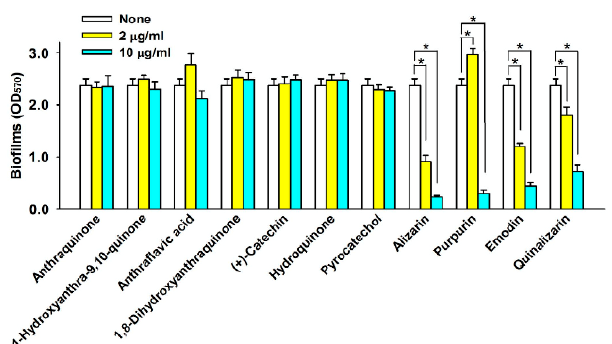
Figure 1. Inhibition effects of cinnamic and salicylic acids on the function of WrbA (from Ref. [49]).